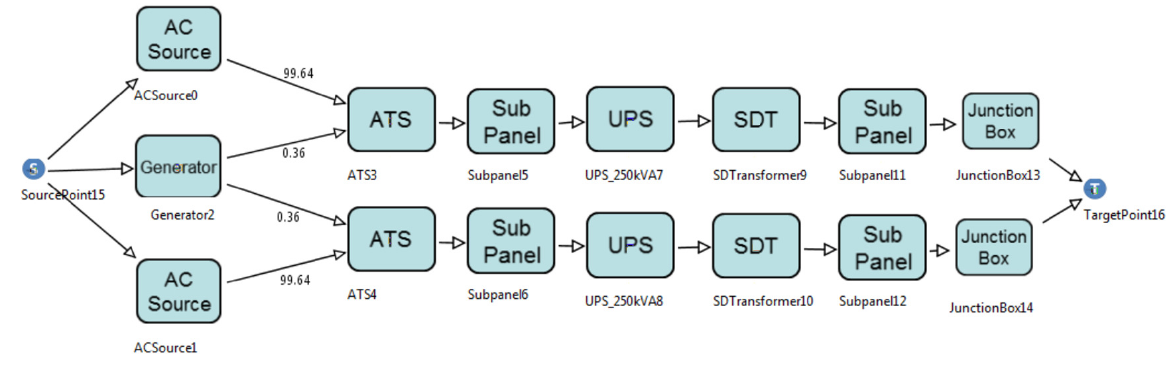
Figure 20. EFM for the power